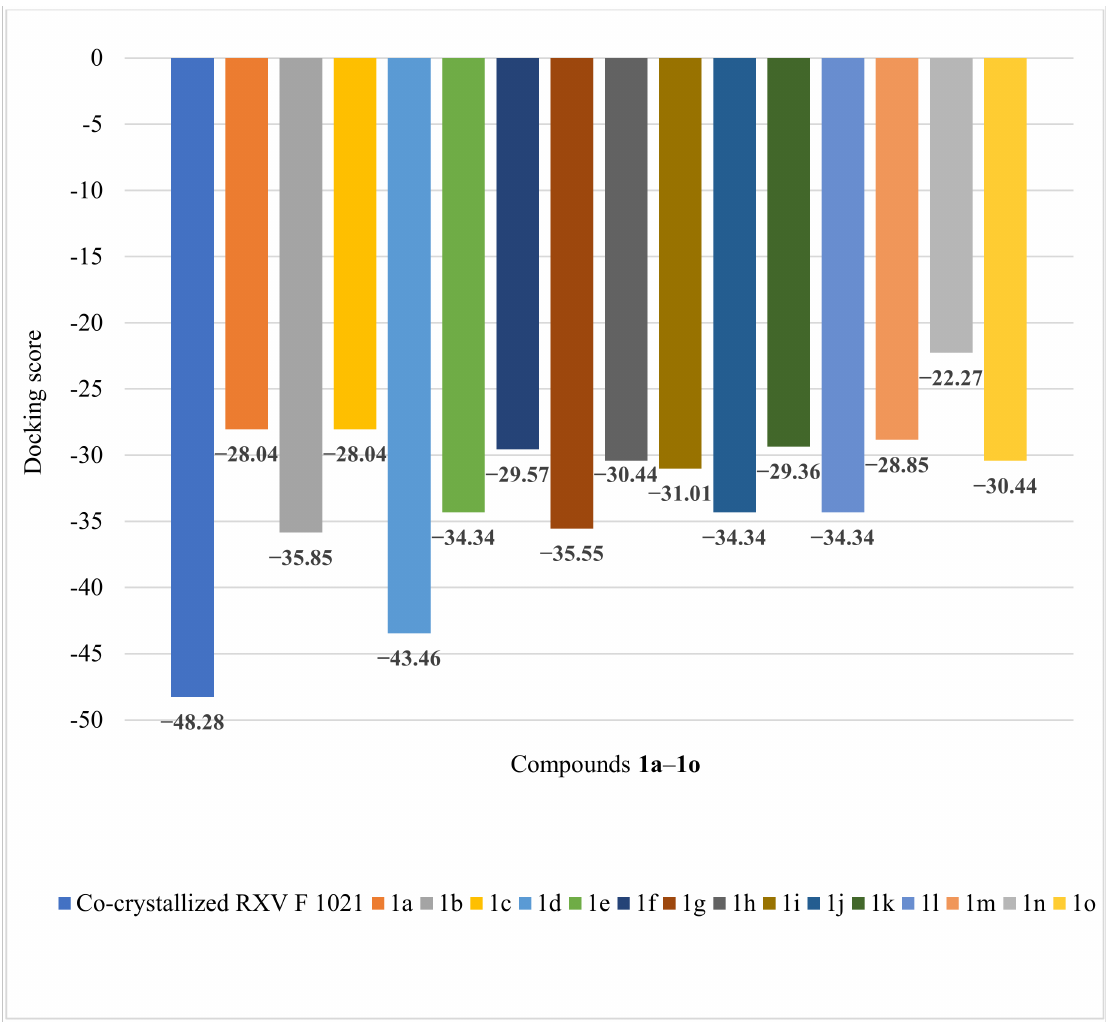
Figure 8. Docking score obtained for the docked compounds 1a – 1o and the target protein 2XCS. Table 9. The list of intermolecular interactions between the ligand molecules docked with